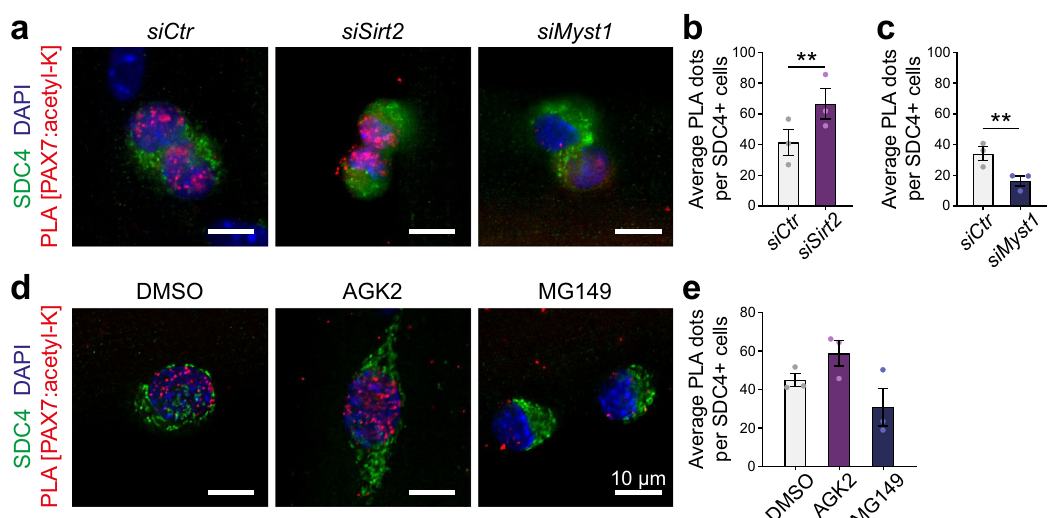
Fig. 4 MYST1 and SIRT2 control the level of PAX7 acetylation in satellite cells. a Representative PAX7:acetylated-lysine PLA (red) performed on satellite cells on cultured myo fi bers following siRNA treatments against Myst1 or Sirt2 , as indicated. Satellite cells are labeled with SYNDECAN-4 (SDC4, green) and nuclei are counterstained with DAPI (blue). Scale bar represents 10 μ m. Images are representative of ≥ 75% of the cells examined ( n = 3 mice). b , c Quanti fi cation of the PLA signals from ( a ), represented as the mean ± SEM. The PLA was quanti fi ed by counting the number of nuclear PLA puncta for each satellite cell. b ( n = 69 siCtrl , n = 61 siMyst1 cells from 3 mice). c ( n = 86 siCtrl , n = 77 siSirt2 cells from 3 mice) (Two-tailed paired t test: ** p = 0.0082 in ( b ); ** p = 0.0096 in ( c )). d Representative PAX7:acetylated-lysine PLA (red) performed on satellite cells cultured on myo fi bers in presence of DMSO, AGK2 or MG149, as indicated. SDC4 marks the satellite cells (green) and nuclei are counterstained with DAPI (blue). Scale bar represents 10 μ m. Images are representative of ≥ 75% of the cells examined ( n = 3 mice). e Quanti fi cation of the PLA signals from ( d ), represented as the mean ± SEM. The PLA was quanti fi ed by counting the number of nuclear PLA puncta for each satellite cell ( n = 107 DMSO, n = 107 MG149, n = 90 AGK2 cells from 3